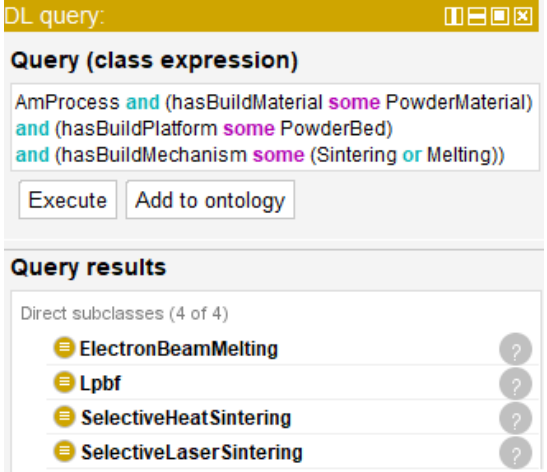
Figure 15. Example of a DL query from the